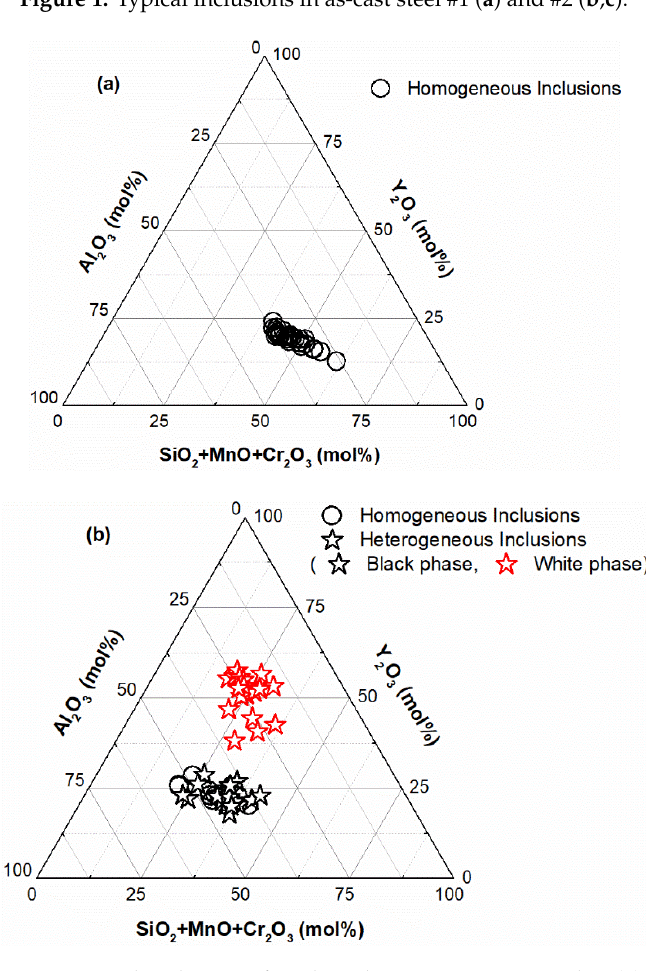
Figure 2. Composition distribution of oxide inclusions in as-cast steel #1 ( a ) and #2 ( b ).